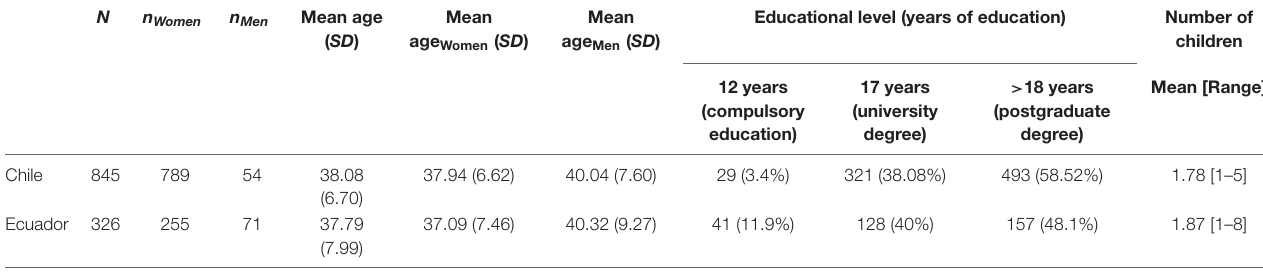
TABLE 6 | Demographic characteristics of the samples in study 2.